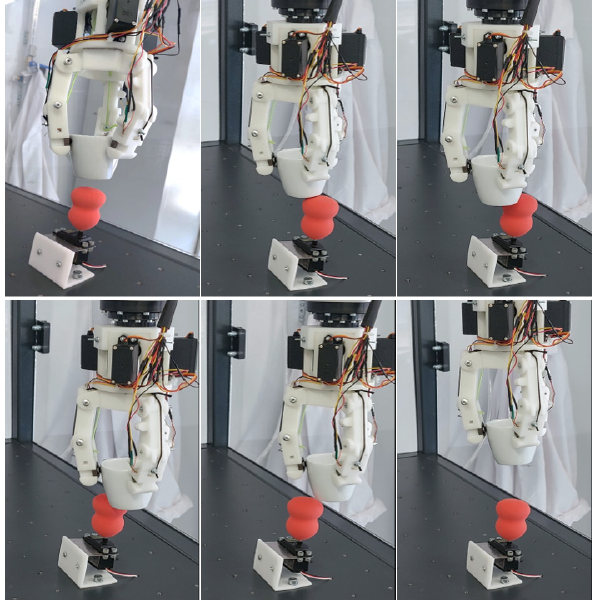
Figure 11. Polishing of the cup handled by the three-toed gripper. Source: (own).